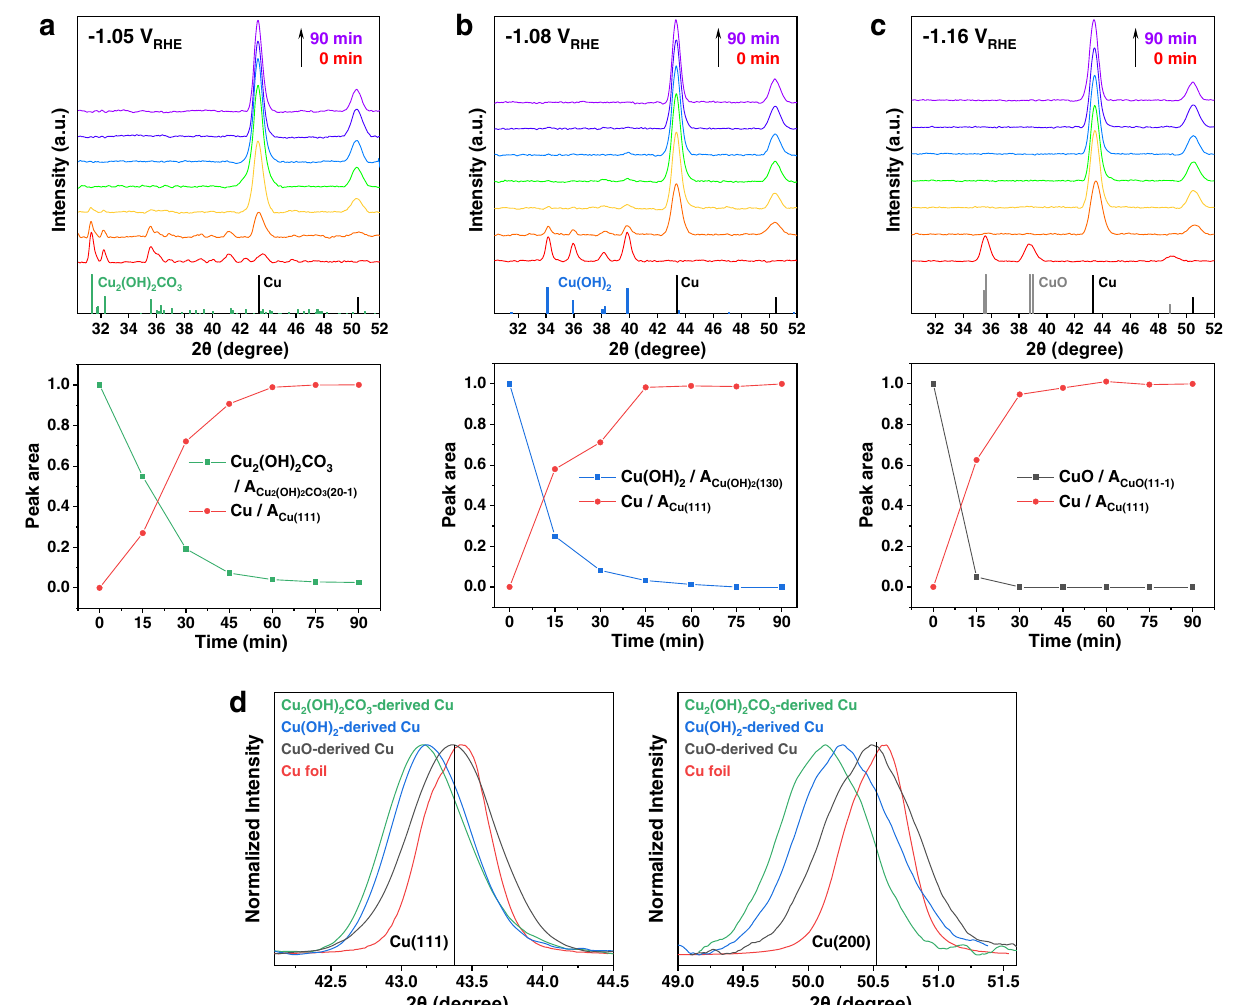
Fig. 3 | The operando X-ray diffraction (XRD) characterizations. Time-resolved operando XRD patterns (upper panel) and the corresponding quantitative peak analysis (lower panel) of a Cu 2 (OH) 2 CO 3 , ( b ) Cu(OH) 2 , and c CuO nanocrystals during the CO 2 RR at their optimum potential for C 2+ production. Spectra were collected every 15min. For the quantitative peak analysis, the integrated and